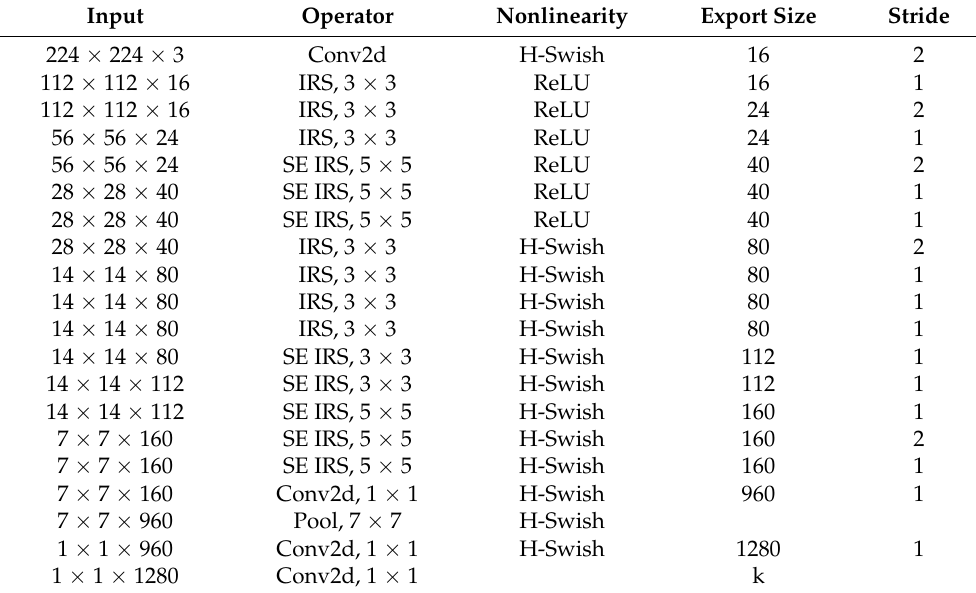
Table 2. MobileNetV3_large network